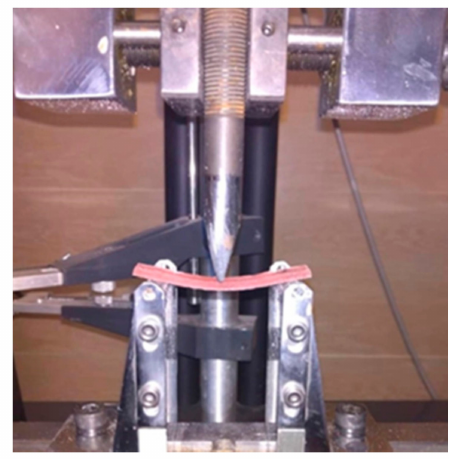
Figure 1. Flexural strength test.